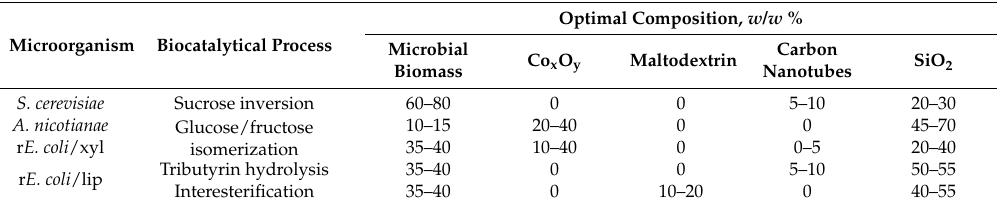
Table 1. Optimal compositions of the whole-cell biocatalysts prepared by immuring non-growing microorganisms inside silica xerogel and nanocarbons-in-silica